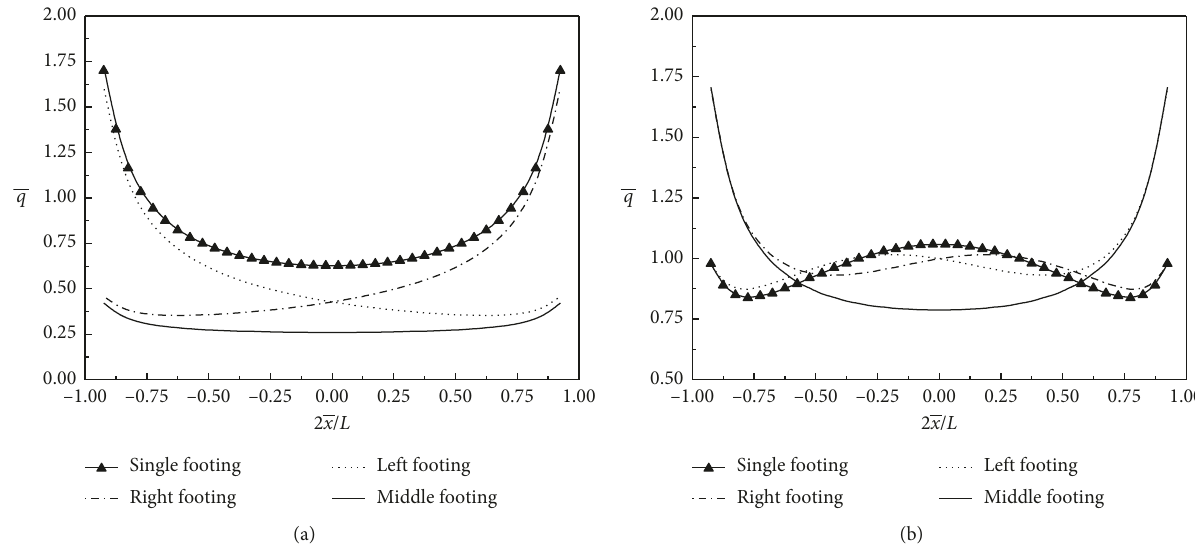
Figure 8: SSSI effect among three strip footings on dynamic contact pressures (footing distance ratio S / L 0.2. (b) a 0 (a) a 0 (cid:31) (cid:31)